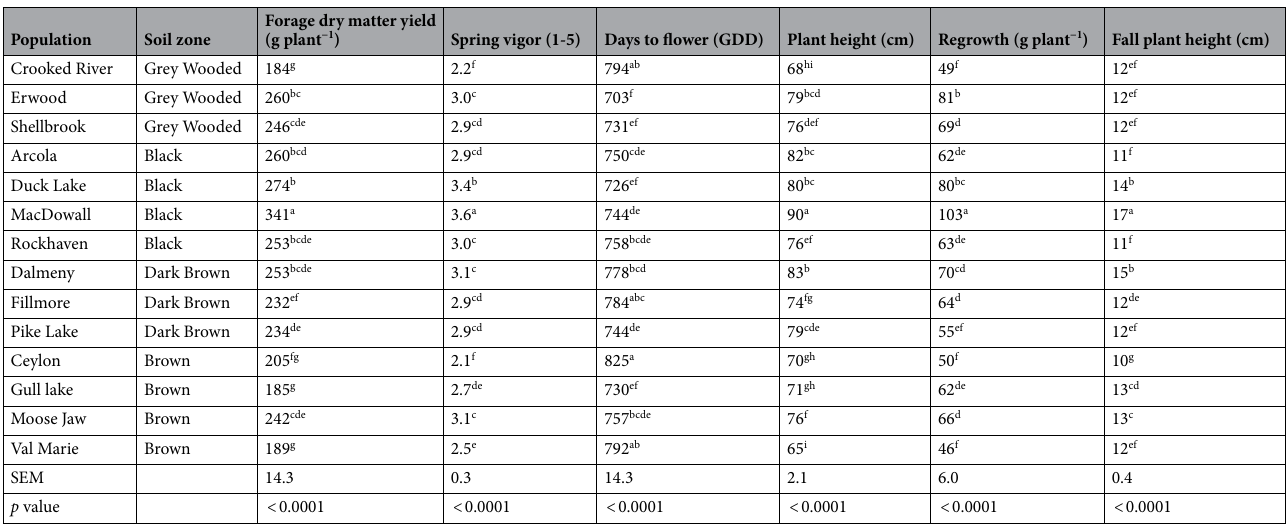
Table 1. Mean comparison of six agro-morphological traits of 14 alfalfa populations with long-term grazing history among four soil zones from 2018–2020 grown at the Agriculture and Agri-Food Canada Saskatoon Research Farm, SK, Canada. Note: The different lowercase letters within a column are significantly different according to Tukey’s HSD at p ≤ 0.05. SEM, standard error of the